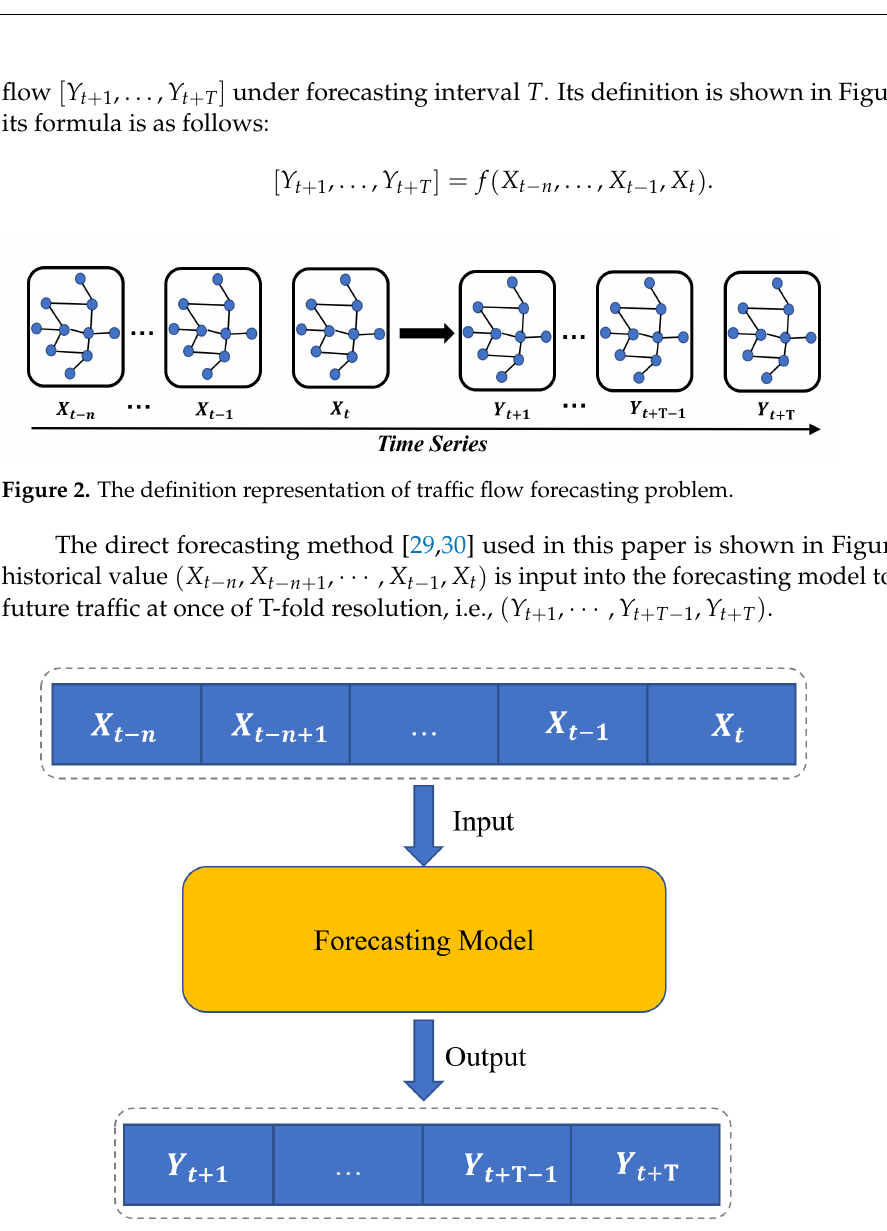
Figure 3. The process of traffic flow